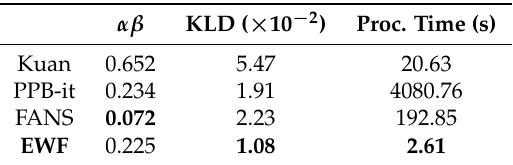
Table 3. Measures for the real Houston City SAR data.